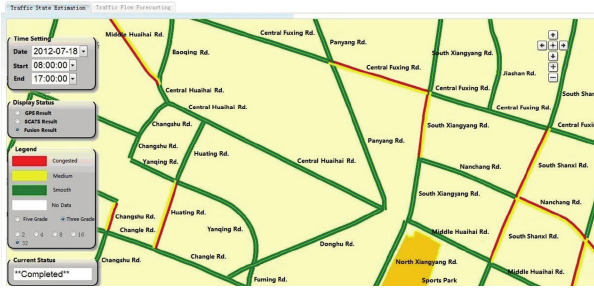
Figure 4: A common portal system serves for Cyber-ITS-based traffic state estimation and traffic flow